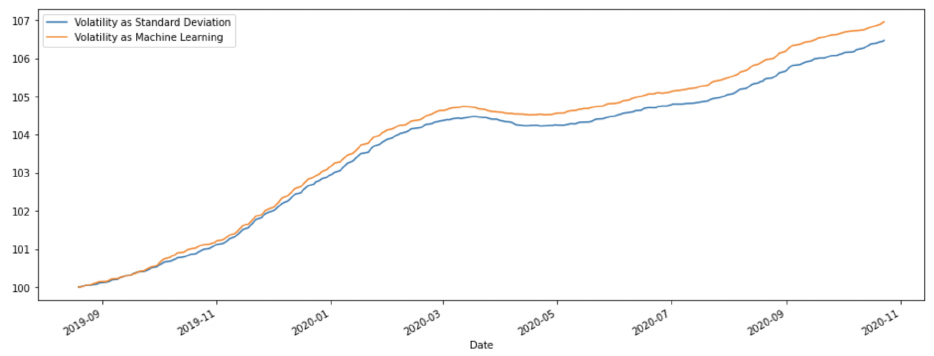
Figure 10. Averaged return from a VolTarget strategy in the year 2020: ML volatility versus realized historical volatility with VT set to 13% (source: authors’